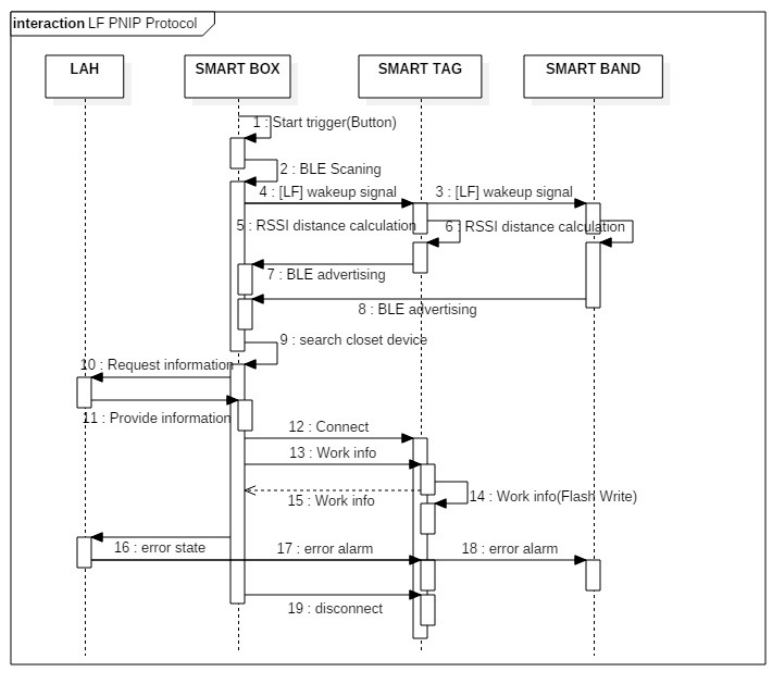
Figure 5. Communication between the LAH, smart box, smart tag, and smart band.